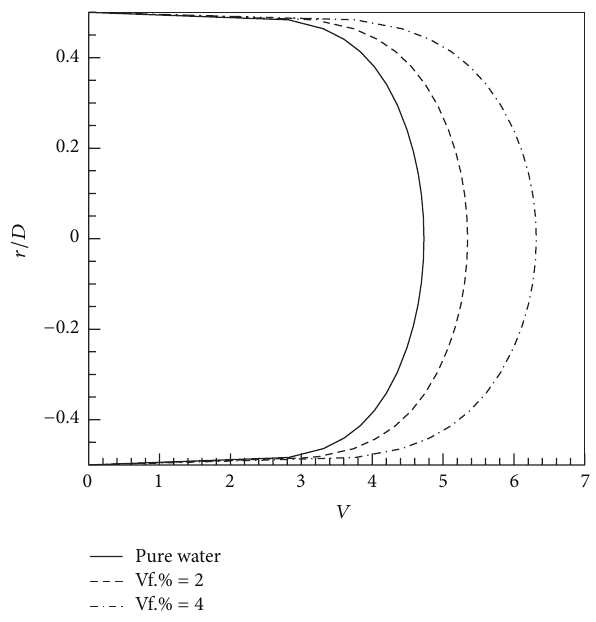
Figure 8: Effect of nanoparticle concentration on fully developed velocity profile for fixed Re =